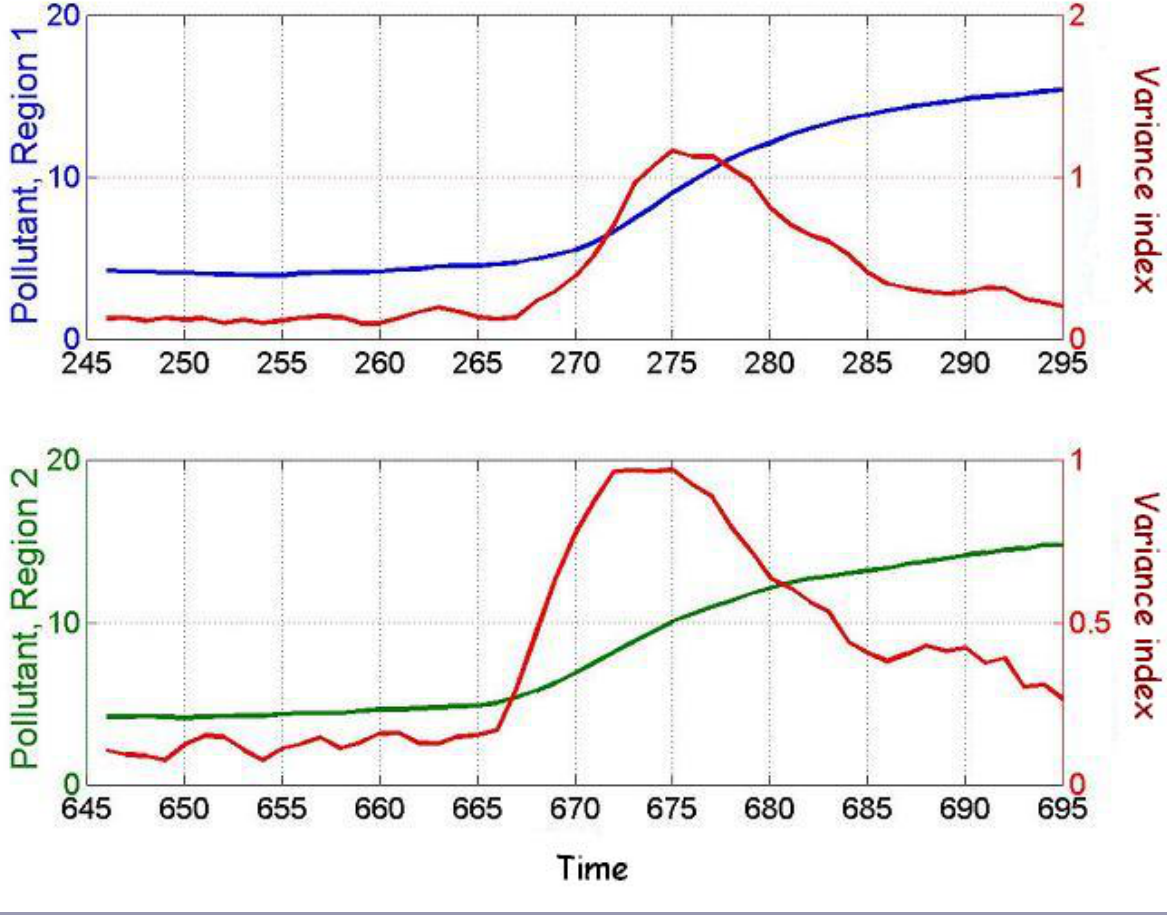
Fig. 8 . Results from Fig. 6 with the time frame narrowed to focus on the regime shifts. In this case, the variance index is smoothed by averaging the previous three observations, i.e., variance index at time t = mean of the variance index at times t, t -1, and t